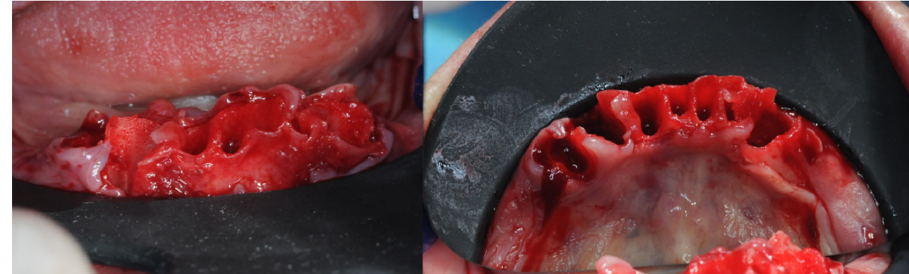
Figure 10. Details of the residual bone after tooth extraction.